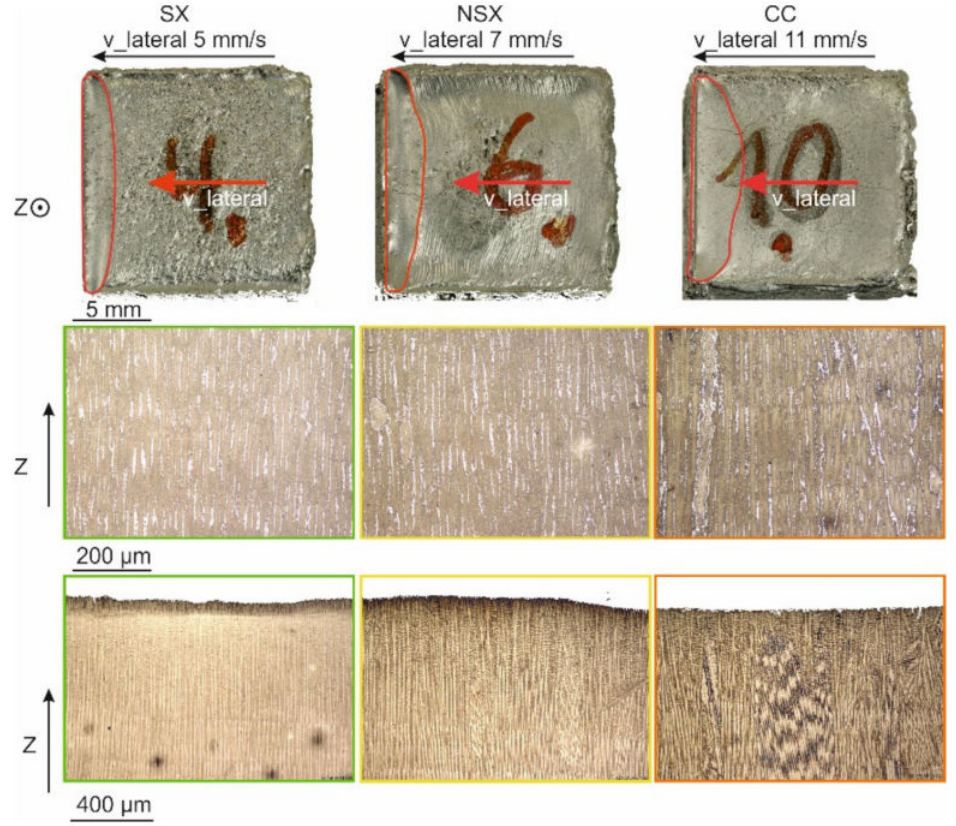
Figure 6. Effect of increasing v_lateral beyond the persistent melt pool threshold at a constant energy input of 6 J/mm 2 and 100 µ m hatch distance. Top: Sample surface with residual melt pool. Middle: Microstructure of the sample centers. Bottom: Microstructure of the top layers.